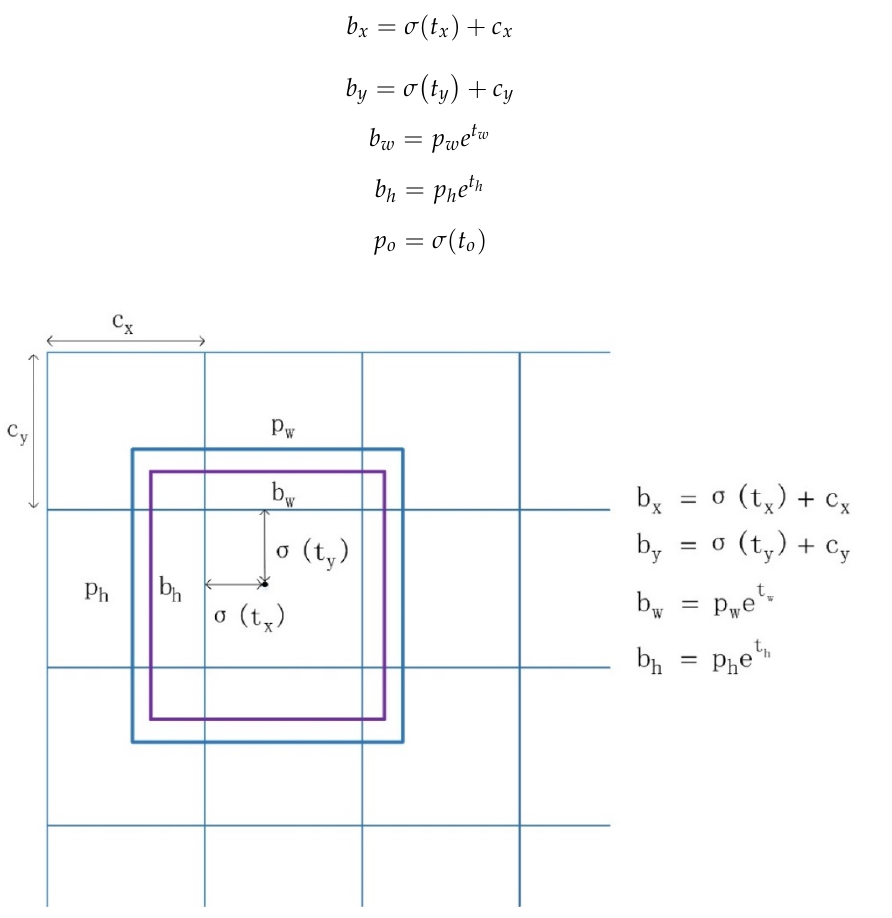
Figure 6. Anchor priors and location prediction. The framework directly generates 4 coordinates (cid:0) (cid:1) t x , t y , t w , t h . The center location of final bounding boxes b x , b y is relative to the grid cell offsets ( c x , c y ) and the sigmoid activation function value of location coordinates ( t x , t y ), where ( c x , c y ) denotes the offsets from the top left corner of the original image to the current grid cell. The width and height of anchor priors is denoted as ( p w , p h ). The σ stands for sigmoid function that limits the values of t x and t y to be